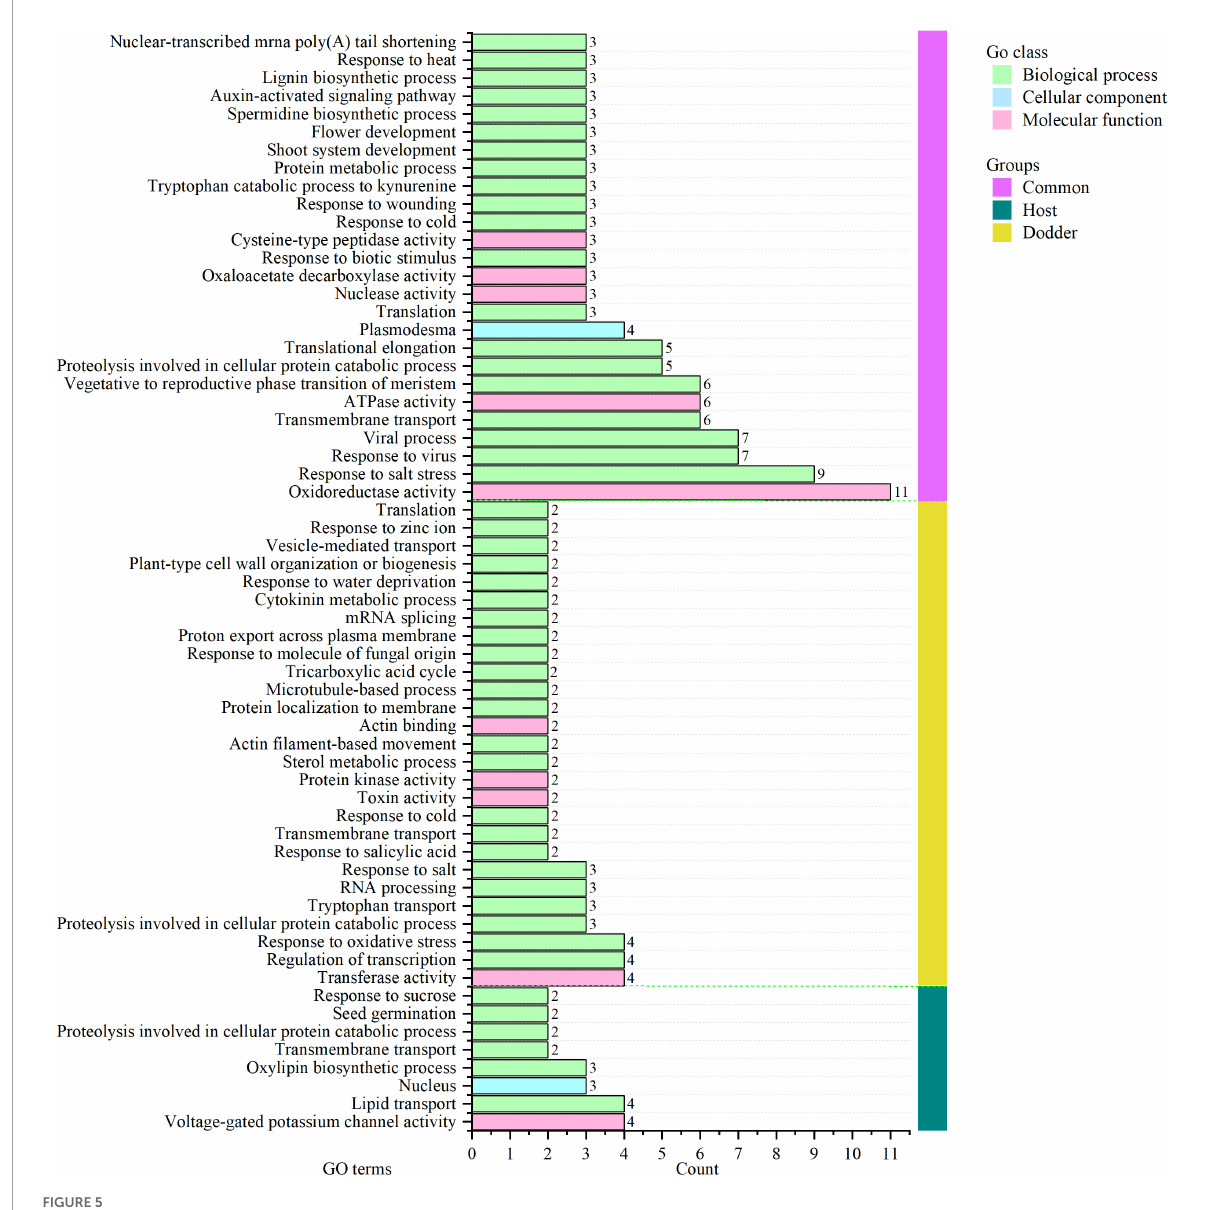
FIGURE5 GO annotation of orthologous clusters of mobile transcripts between dodder and hosts. Common group (vertical pink bar), homologous clusters of mobile transcripts identified from dodder and citrus/periwinkle. Host group (vertical green bar), homologous clusters of mobile transcripts from citrus and periwinkle. Dodder group (vertical yellow bar), unique clusters of mobile transcripts from dodder. The count of mobile transcripts in each GO terms was indicated as the horizontal bar with the number listed in the right. The detailed GO information of mobile transcripts was listed in Supplementary Table 4